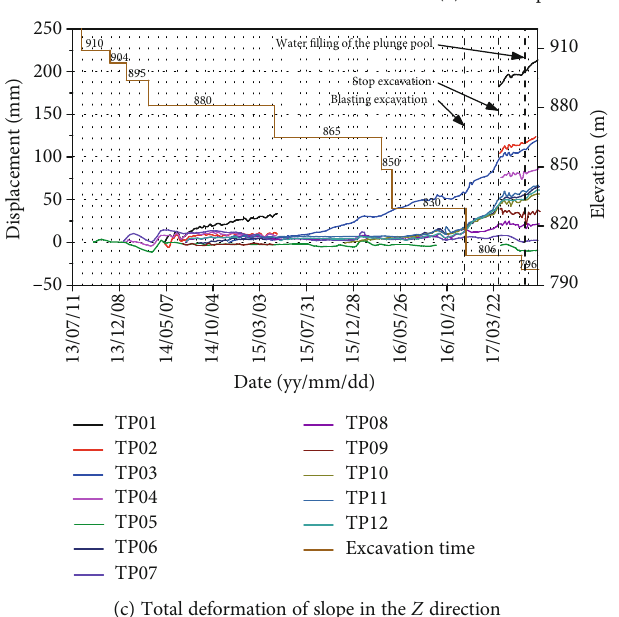
Figure 7: Comparison curve between the total deformation of apparent monitoring and the excavation